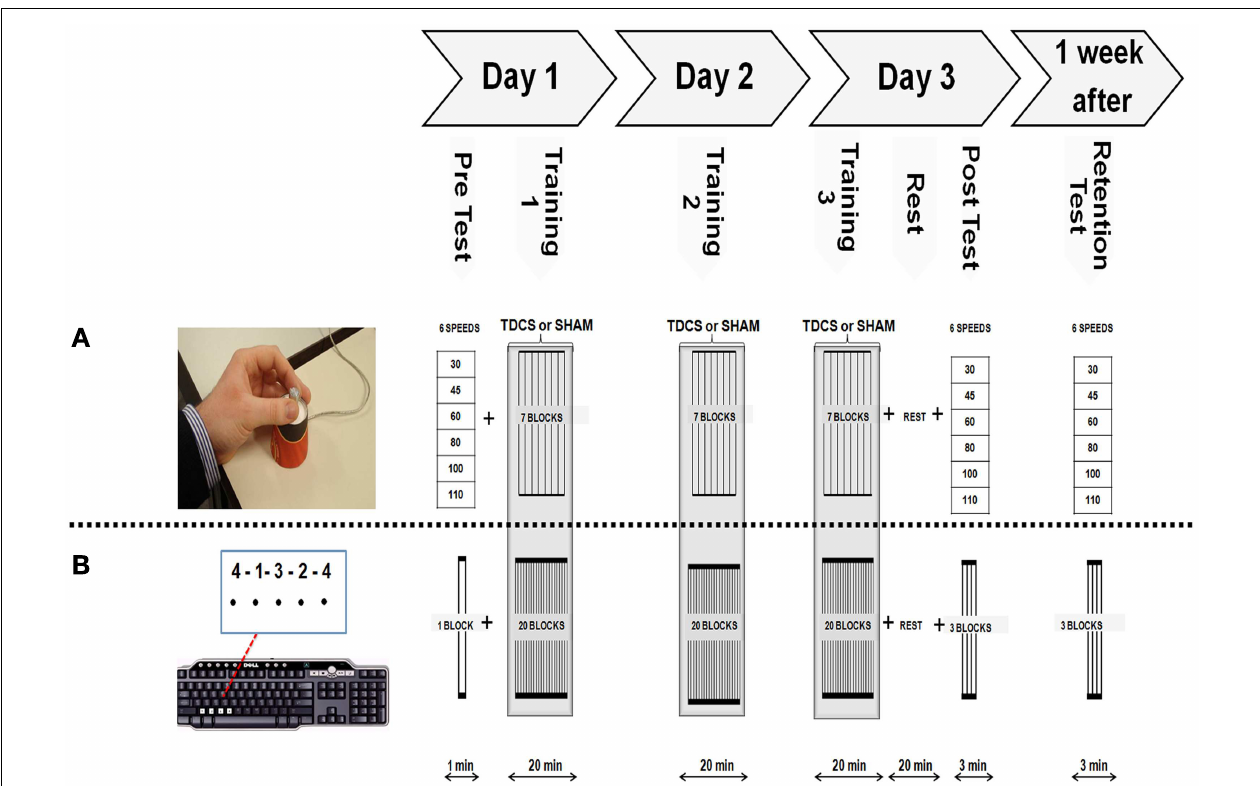
series of target zones, as fast and accurately as possible. (B) The sequential finger tapping task (SEQTAP) required subjects to repeatedly tap a fixed five element sequence with their left hand, as fast and accurately as possible on a